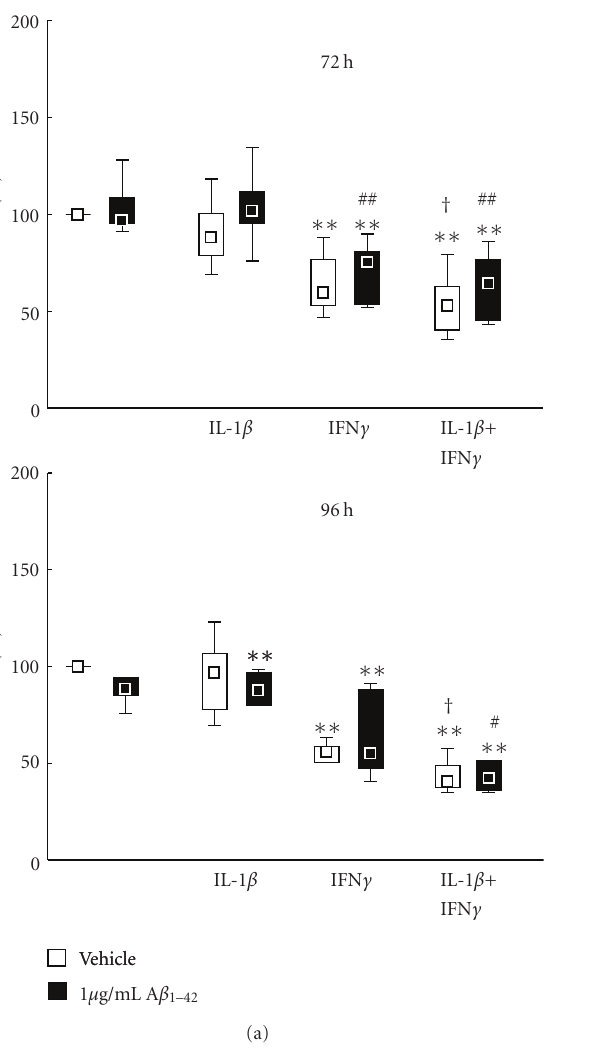
significantly increased the levels of IL-6 several-fold ( P < .